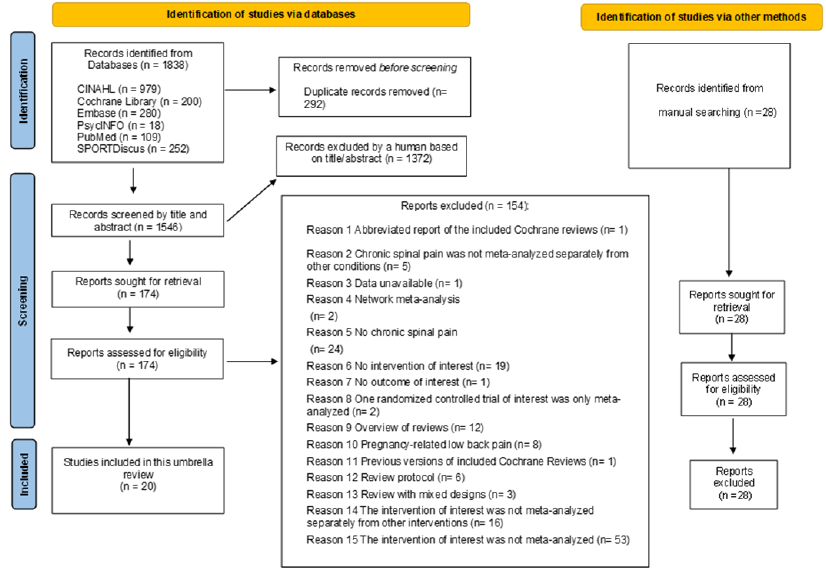
Figure 1. Flow diagram.